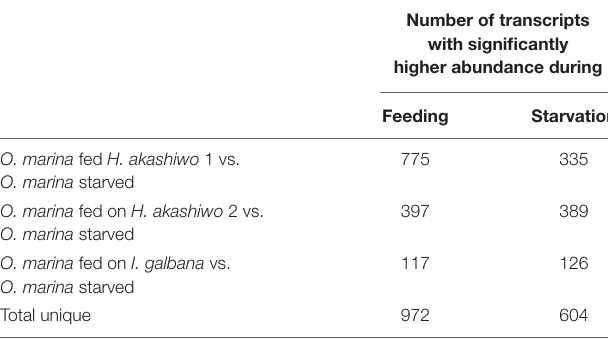
TABLE 4 | Number of significantly differentially expressed transcripts (posterior probability ≥ 0.950 and fold change ≥ 2) in O. marina cells fed with three different prey types (two strains of H. akashiwo : H. akashiwo 1, H. akashiwo 2, and I. galbana ) in comparison to O. marina cells kept in starvation for 4 days after prey depletion.